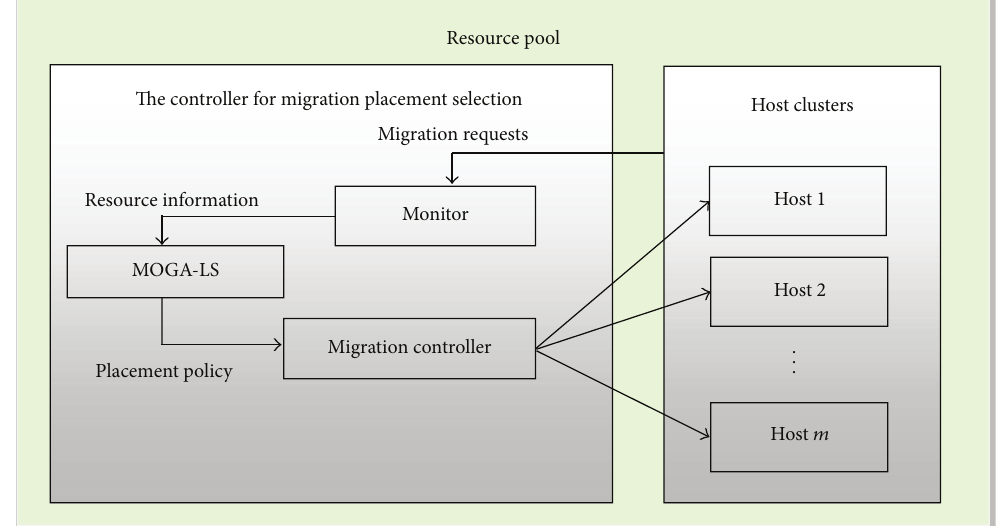
Figure 3: The view of MOGA-LS’s